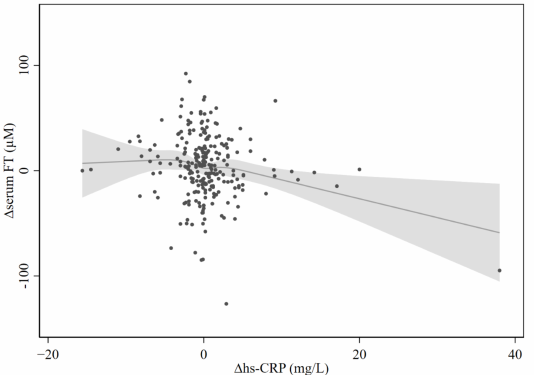
Figure 3. Estimated associations of ∆ FT with ∆ hs-CRP (three months—baseline) based on restricted cubic splines. The figure shows restricted cubic splines with scatter plot of ∆ FT and ∆ hs-CRP (three months—baseline). A dot represents one case. The regression line for each spline segment for ∆ FT levels is connected with smoothed transitions. The gray area represents the 95% CI. The restricted cubic spline regression does not reveal significant deviations from linear associations. Abbreviations: